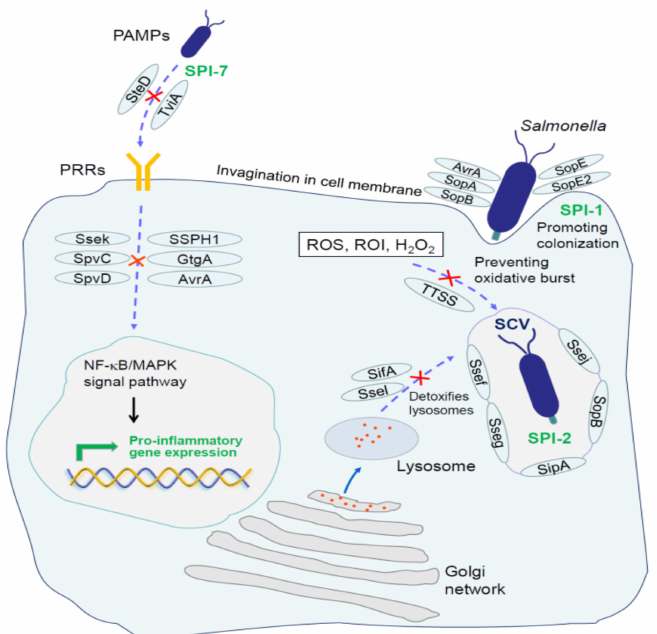
Figure 1. Role of Salmonella T3SS e ff ectors in epithelial cells and macrophages. SopB, SopD, SopE, and AvrA are essential for membrane invasion during Salmonella infections. SipA, SseJ, SopE2, and SopB are required for biogenesis and correct localization of SCV. SifA and SopD2 contribute to evasion of lysosomal degradation. SPI-7 e ff ector TviA is mainly responsible for masking the surface antigens, leading to the failure of PRRs to recognize them. Several e ff ectors including SseL, GtgA, GogA, PipA, SpvC, and SpvD inhibit the innate immune signaling, and subsequently diminish the production of proinflammatory mediators and result in an ine ffi cient clearance of phagocytized bacteria. Salmonella can also prevent the interaction of NADPH oxidase subunit Cytb558 with SCV and escape from the oxidative burst depends on T3SS. PAMP: Pathogen-associated molecular pattern; PRR: Pattern recognition receptor; ROS: Reactive oxygen species; ROI: Reactive oxygen intermediates; SCV: Salmonella -containing vacuole; SPI: Salmonella pathogenicity islands; NF- κ B: Nuclear factor kappa beta; MAPK: Mitogen-activated protein